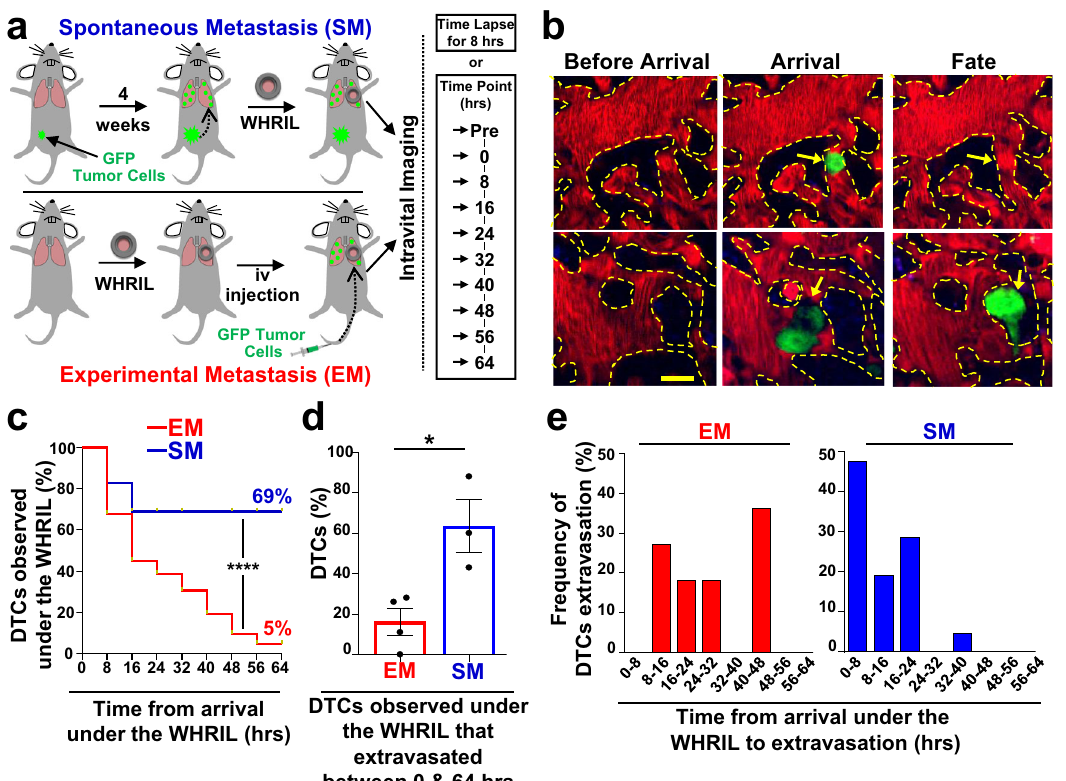
Fig. 1 Tumor cells that spontaneously disseminate from the primary tumor to the lung have a drastically increased metastatic ef fi ciency compared to intravenously injected tumor cells. a Experimental design to track the fate of individual disseminated tumor cells using an Experimental Metastasis (EM) model (top) and a Spontaneous Metastasis (SM) model (bottom). b Serial imaging through the WHRIL allows tracking of the fate of disseminated tumor cells. Vasculature before arrival (left), upon arrival (middle) and after arrival of tumor cells (TCs). Fate of TCs (yellow arrows) could be either recirculation or apoptosis (right, top) or extravasation into the lung parenchyma (right, bottom). Red = tdTomato labeled endothelial cells and 155 kDa Tetramethylrhodamine dextran labeled blood serum, Green = GFP labeled tumor cells, Blue = second harmonic generation. Scale bar = 15 μ m. c Kaplan- Meier survival curves showing the percentage of E0771-GFP tumor cells observed under the WHRIL at each 8 hr time point over a period of 64 hrs. EM: n = 62 tumor cells analyzed in 3 mice. SM: n = 29 tumor cells analyzed in 3 mice. Log-rank (Mantel-Cox) test ( p < 0.0001). **** p < 0.0001. d Percentage of E0771-GFP EM and SM tumor cells observed under the WHRIL that extravasated between 0 and 64 hrs after arrival. EM: n = 89 tumor cells in 4 mice. SM: n = 29 tumor cells in 3 mice. Bar = mean. Error bars = ±SEM. Unpaired two-tailed t -test ( p = 0.017). * p < 0.05. e Quanti fi cation of the time from arrival under the WHRIL to extravasation into the lung parenchyma for each E0771-GFP EM and SM tumor cell. Left: EM: n = 11 tumor cells in 3 mice. Right: SM: n = 21 tumor cells in 3 mice. Source data are provided as a Source Data fi